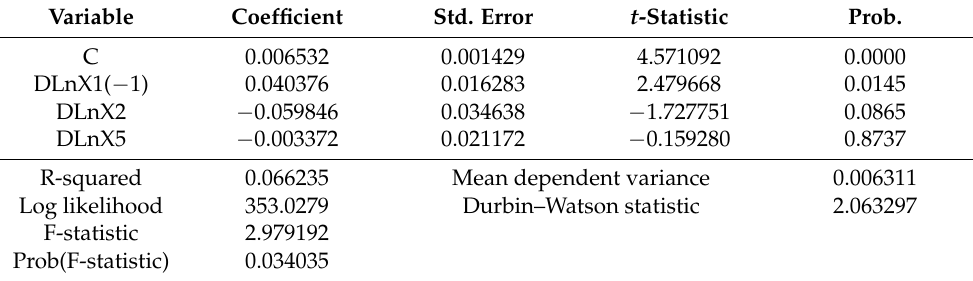
Table 6. Role of high yield spread. Method: least squares. Sample: 2009M07 2020M04. Included observations: